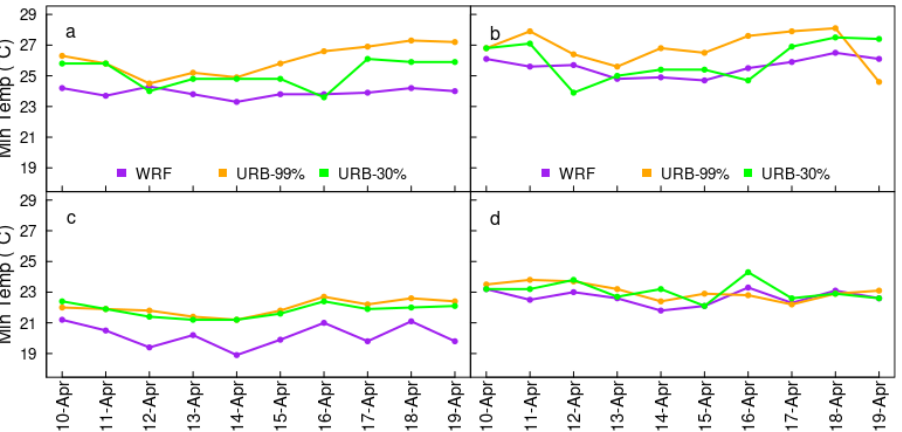
Figure 10. Daily minimum near-surface (2m) air temperature for current LULC, high-urbanization (URB_99%), and low-urbanization (URB_30%) scenarios at ( a ) Dar, ( b ) Dar-Port, ( c ) Morogoro, and ( d ) Kibaha stations. Table 7. Daily minimum temperature difference (°C) between future urbanization scenarios and current LULC at four stations.